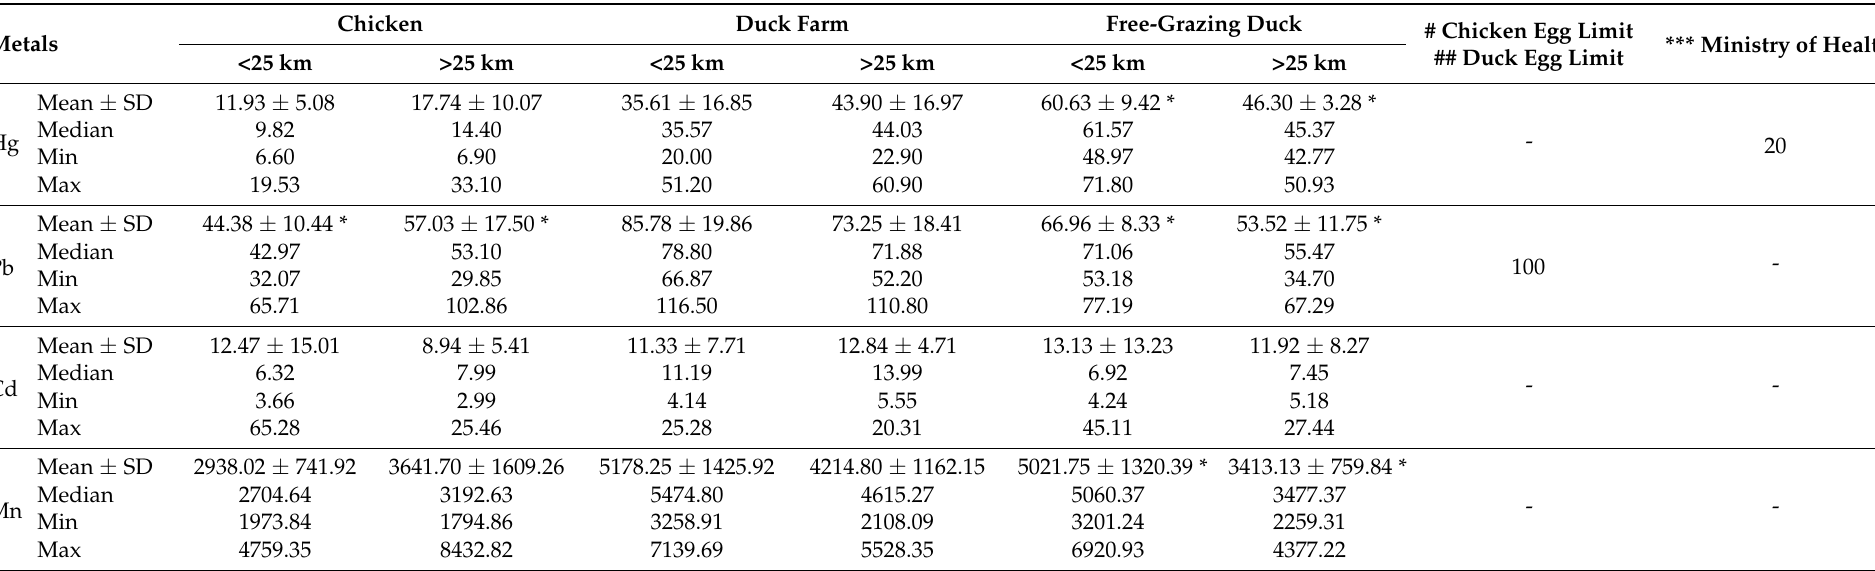
Table 1. Mean ± SD, the median, minimum, and maximum values of Hg, Pb, Cd, and Mn concentrations in poultry egg ( µ gkg − 1 dry